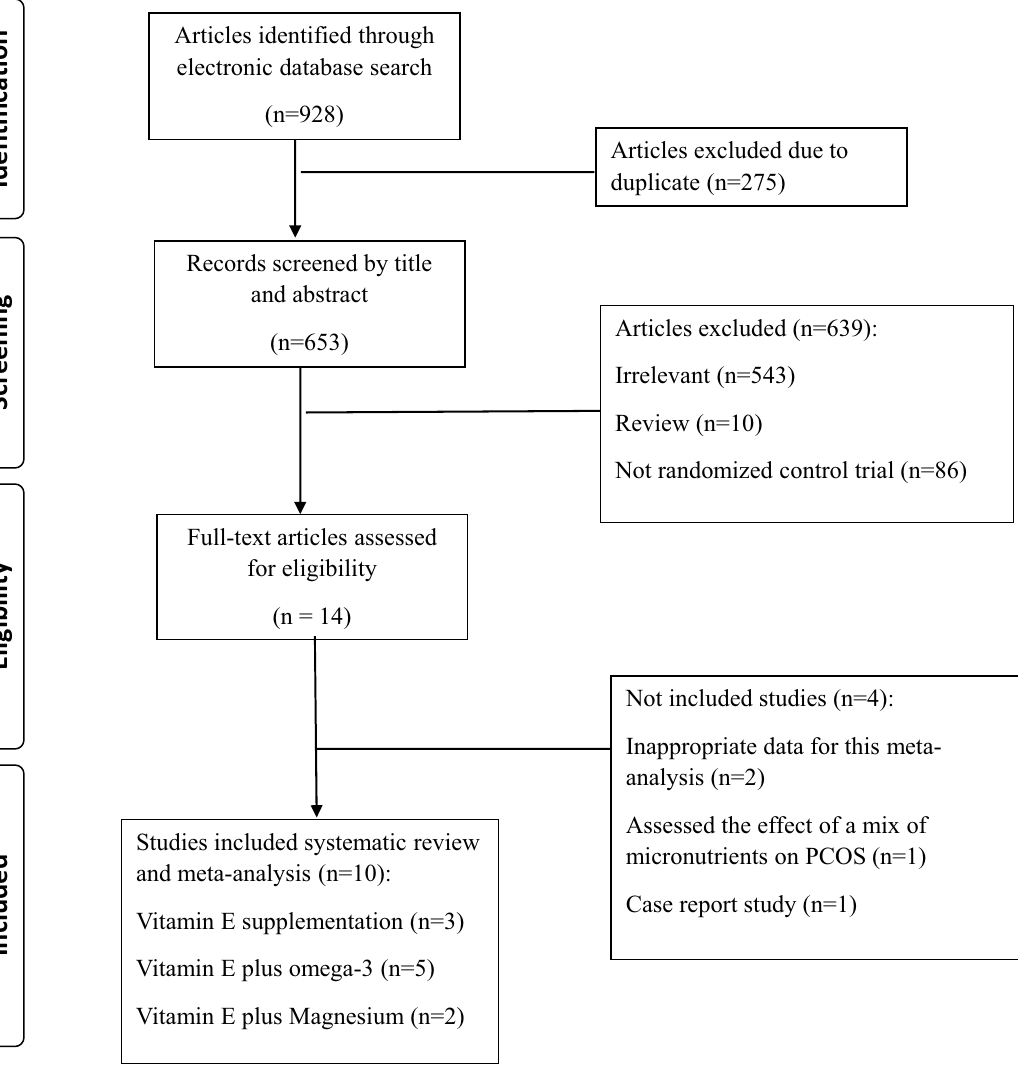
Figure 1. Flow chart of the systematic search and study